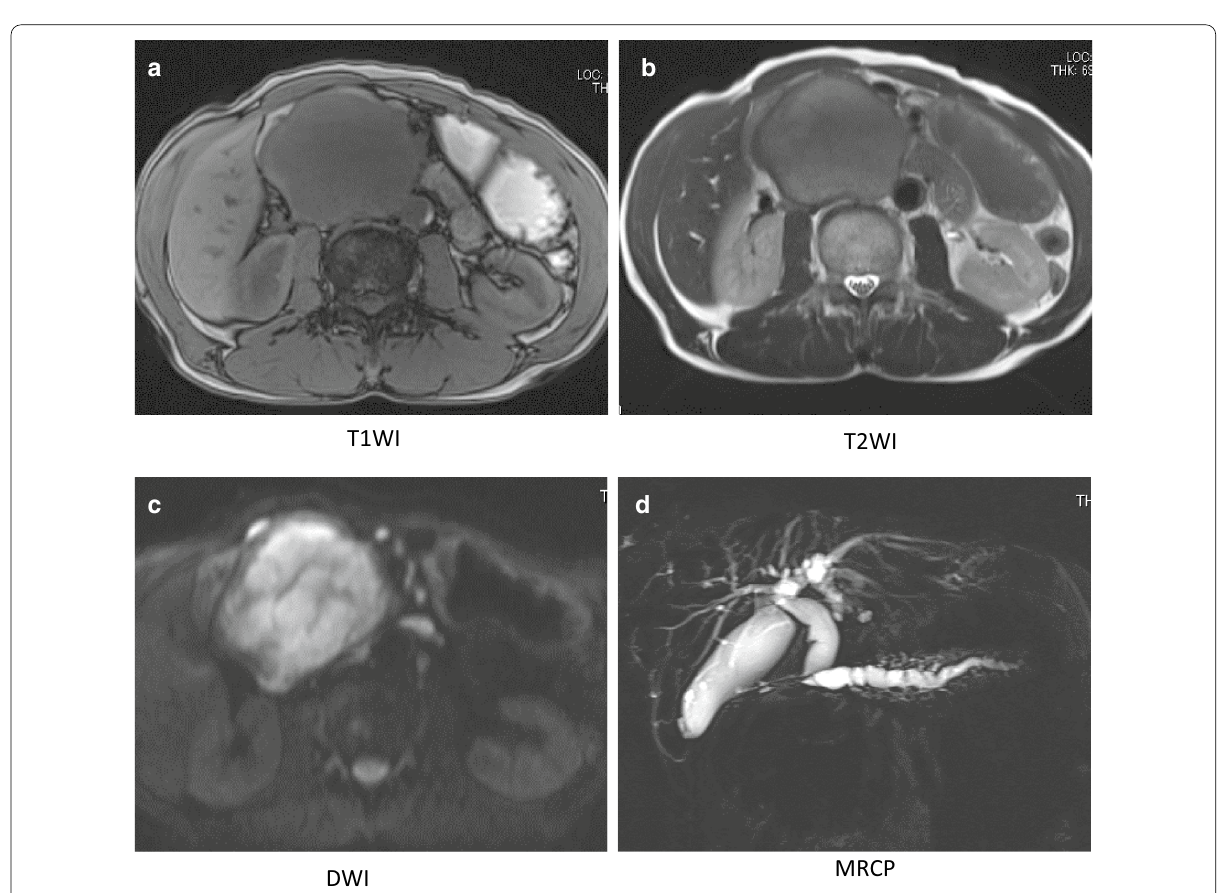
Fig. 2 Abdominal MRI. MRI shows the tumor in the pancreatic head, with low signal intensity on T1-weighted imaging ( a ), low signal intensity on T2-weighted imaging ( b ), and high signal intensity on diffusion-weighted imaging ( c ). MR cholangio-pancreatography showing dilatation of intra- and extra-hepatic bile ducts and the pancreatic duct owing to tumor obstruction ( d